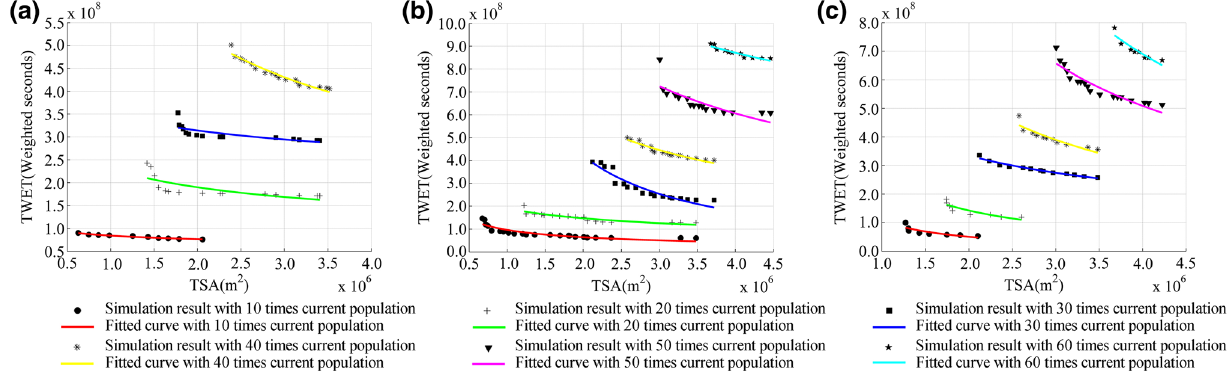
Fig. 4 Relationships between total shelter area (TSA) and total weighted evacuation time (TWET) at various evacuation population levels with different community locations. a Location 1, the current